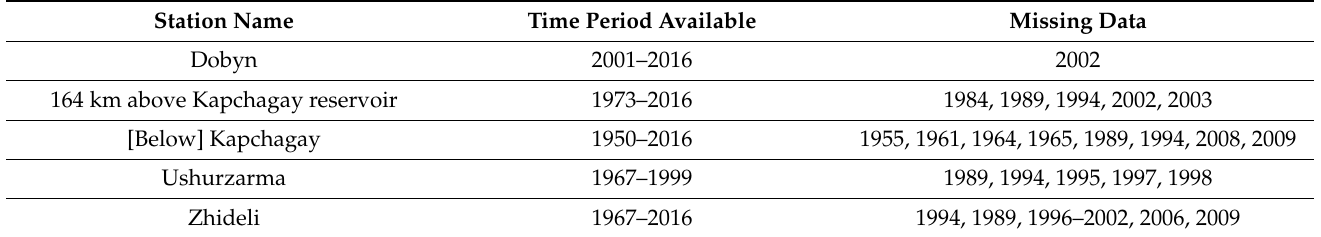
Table A3. Hydrological data completeness.